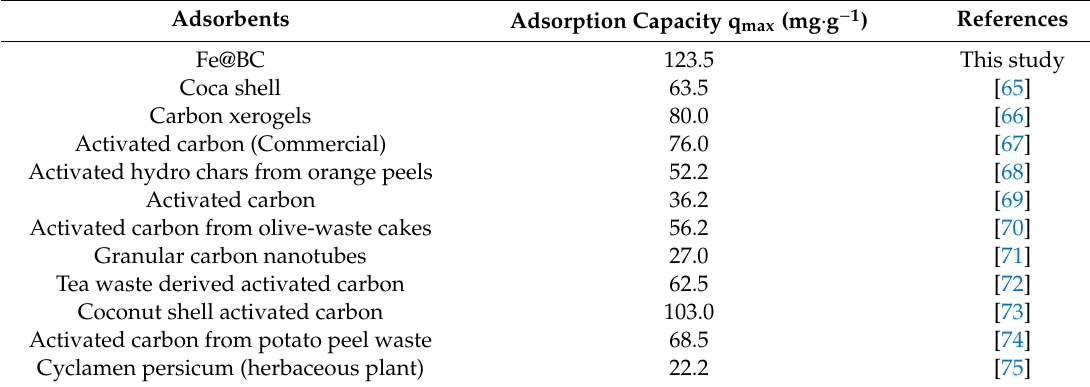
Table 5. DCF adsorption capacity of various adsorbents and Fe@BC.